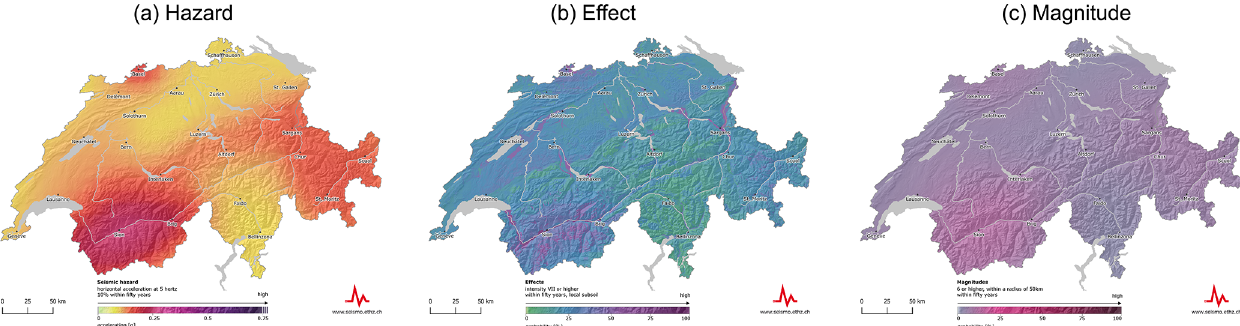
Figure 2. Comparison of the color scales of the three map types offered for the release of the updated seismic hazard model: (a) hazard map (in units of ms 2 ), (b) effect map (in units of EMS intensity), and (c) magnitude map (in units of magnitude; Swiss Seismological Service, 2018; http://www.seismo.ethz.ch/knowledge/seismic-hazard-switzerland/).